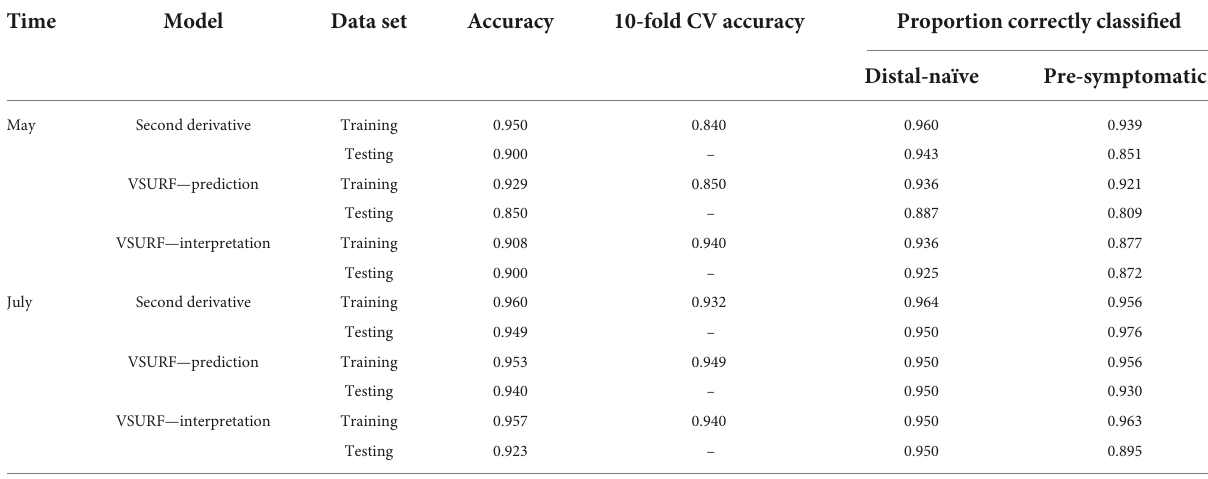
TABLE 2 Accuracies of the three distinct random forest models used to classify leaf near-infrared (NIR) spectra based on tree symptom type for the May and July datasets. Time Model